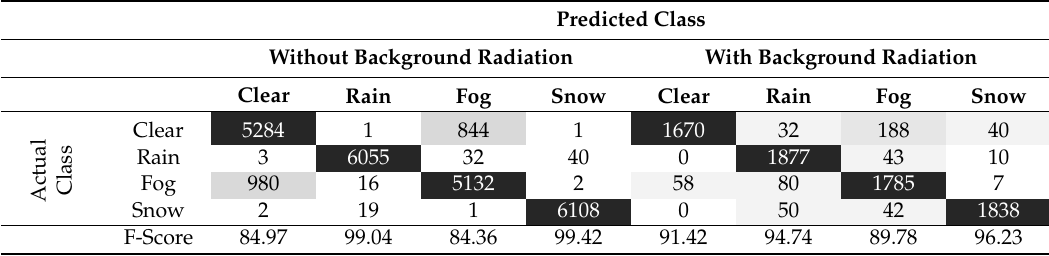
Table 5. Confusion matrix for the atmosphere region without background radiation (left, 6130 samples per class) and with background radiation (right, 1930 samples per class) (classifier: Weighted